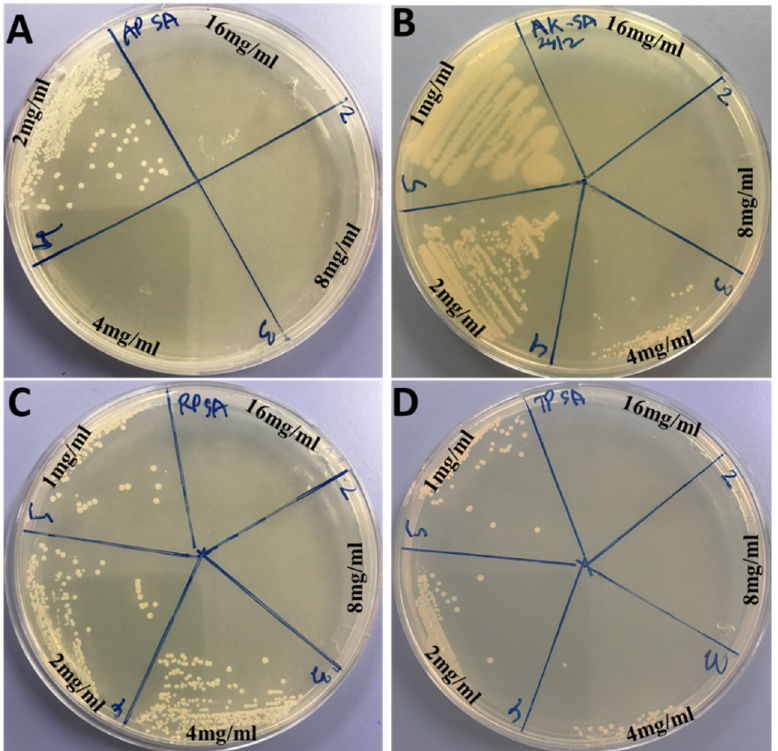
Figure 4. MHA plates showing MBC values for S. aureus ATCC 25923. Plate ( A ) showing MBC value of 4 mg/mL for Ag 3 PO 4 , ( B ) 8 mg/mL for Se-Ag 3 PO 4 , ( C ) 8 mg/mL for Ag-Ag 3 PO 4 , and ( D ) 8 mg/mL for Ta-Ag 3 PO 4 , respectively.